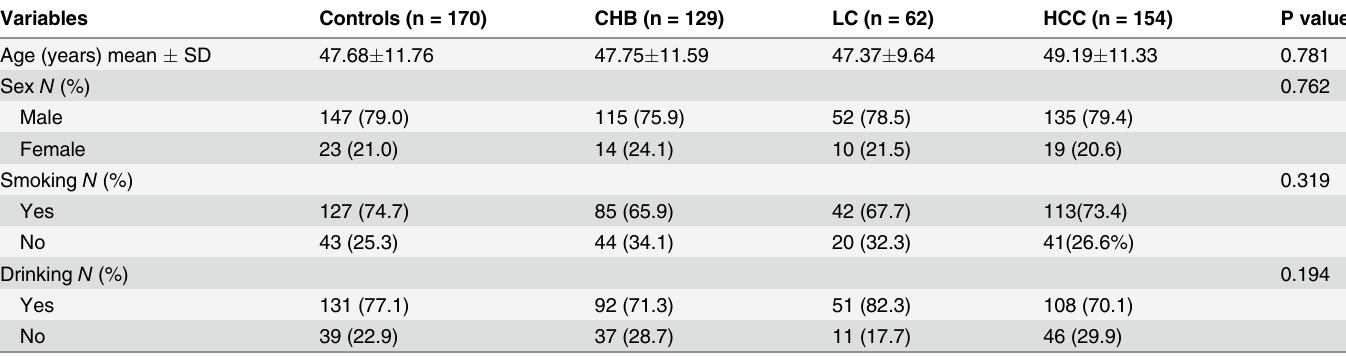
Table 1. Demographic characteristics of the study